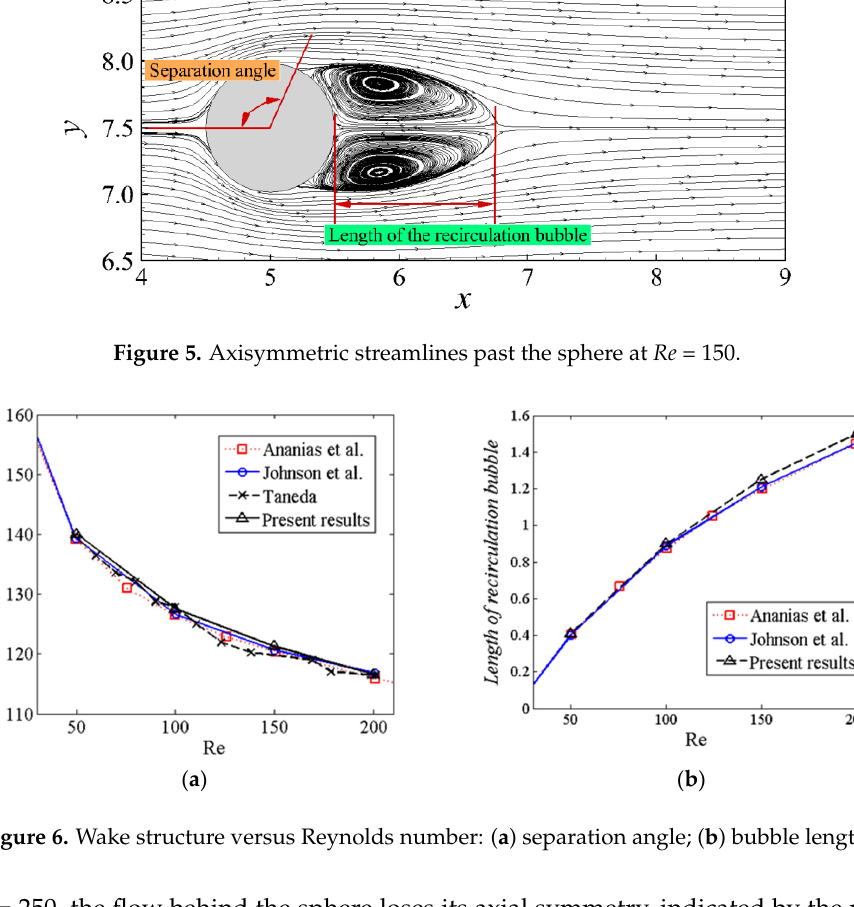
Table 1. Drag coefficient (cid:1829) (cid:3031) for the flow past a sphere at different Reynolds ( Re ) number.